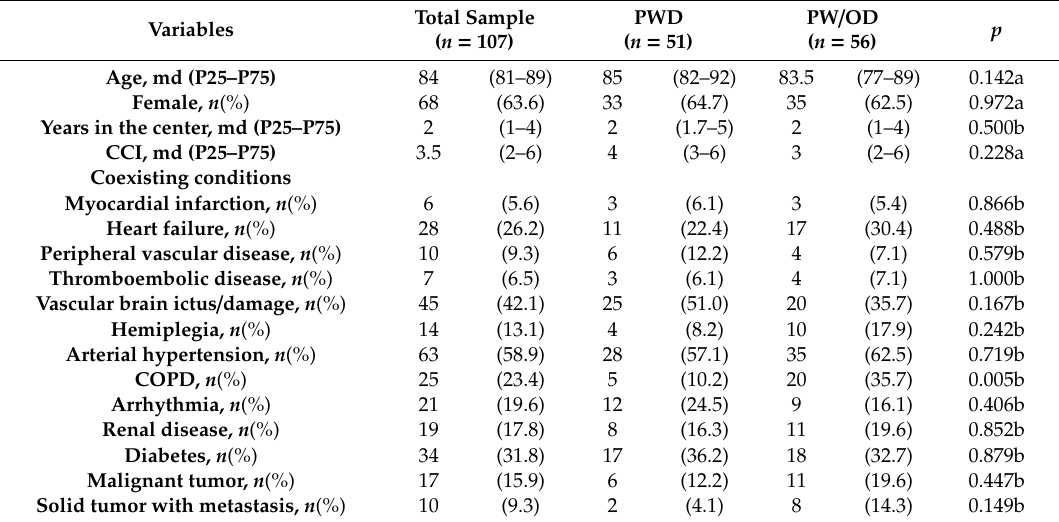
Table 1. Sociodemographic and clinical characteristics of the patients.